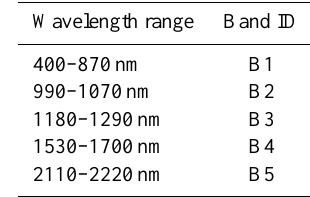
Table 2. Wavelength ranges for bands